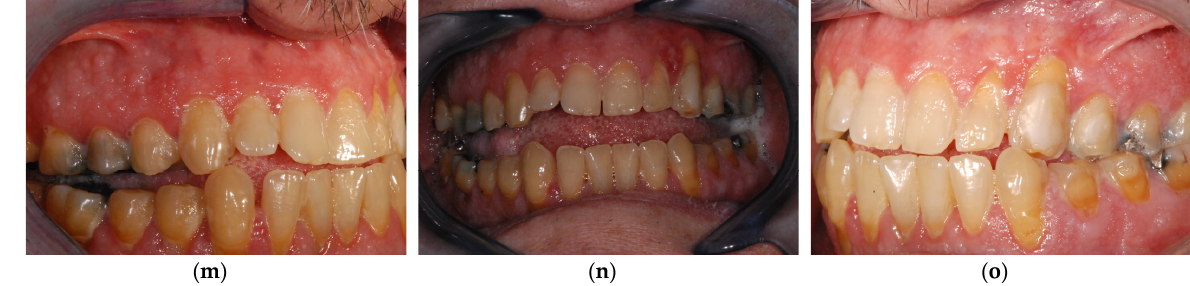
Figure 5. Patient 4 clinical history. First evaluation ( a ) Right lateral lingual border. ( b ) mucosal side of the lower lip. ( c ) Palate. After 4 years follow-up patient complained about very marked gingival hypertrophy ( d ) Palate. ( e – g ) Gingival aspect. ( h , i ) Tongue lesion. ( j – o ) mucogingival plastic surgical approach results.